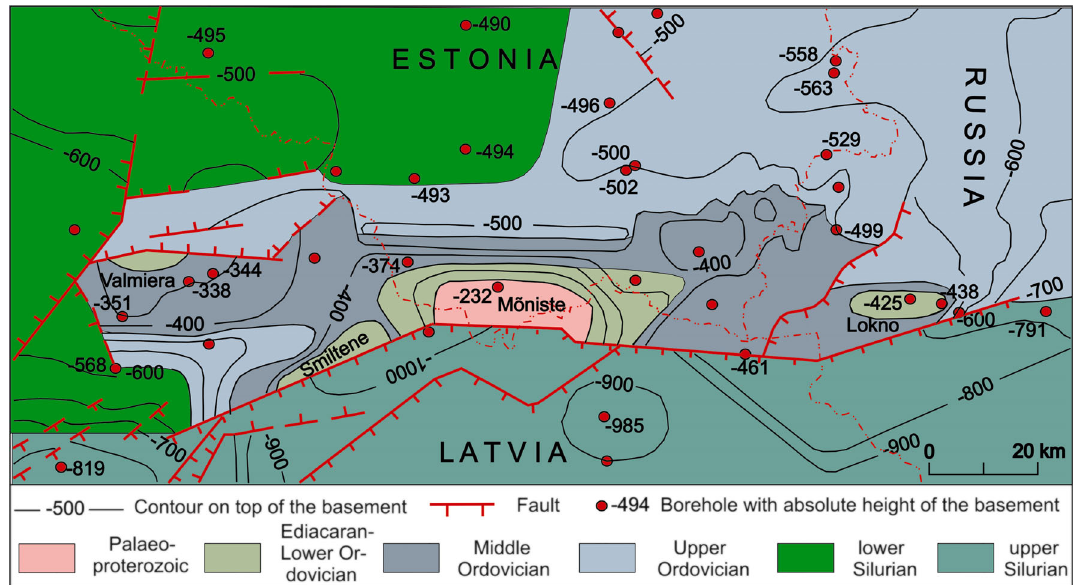
Fig. 10. Subcrop map revealing erosional inlier below the lowermost Devonian unconformity on the uplifted VLU area plotted against the structure contours on top of the crystalline basement (after Tuuling & Vaher